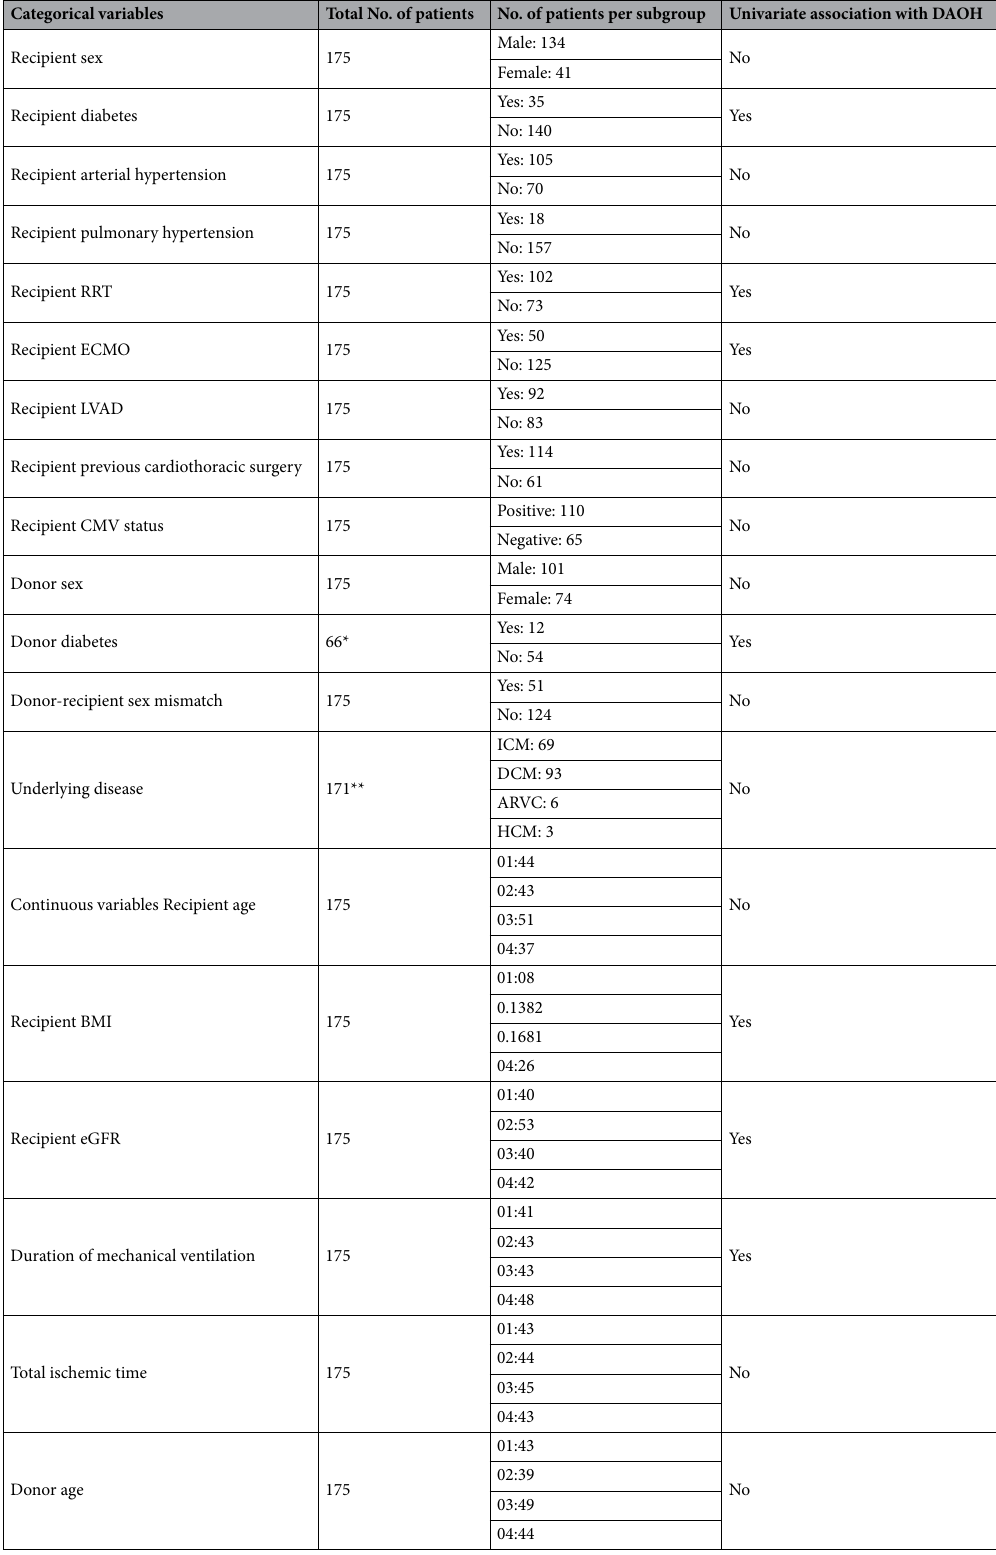
Table 3. Variables investigated for association with days alive and out of hospital in univariate analysis. BMI Body mass index (kg/m 2 ), CMV cytomegalovirus, ECMO extracorporeal membrane oxygenation,